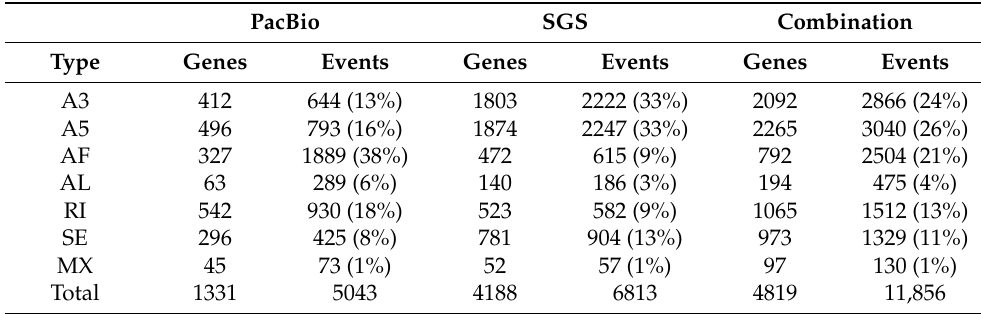
Table 1. Alternative splicing events in splicing isoforms identified in Iso-Seq and RNA-Seq data by